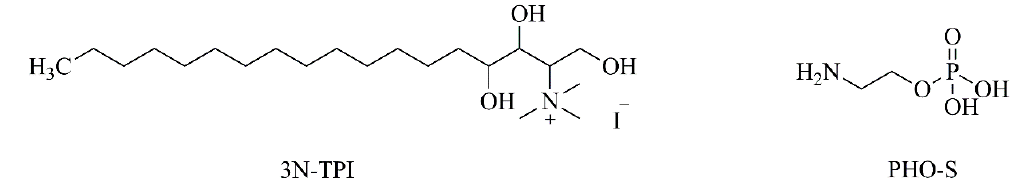
Figure 13. Chemical structures of N , N , N -trimethylphytosphingosine-iodide (3N-TPI) and phosphoethanolamine (PHO-S).